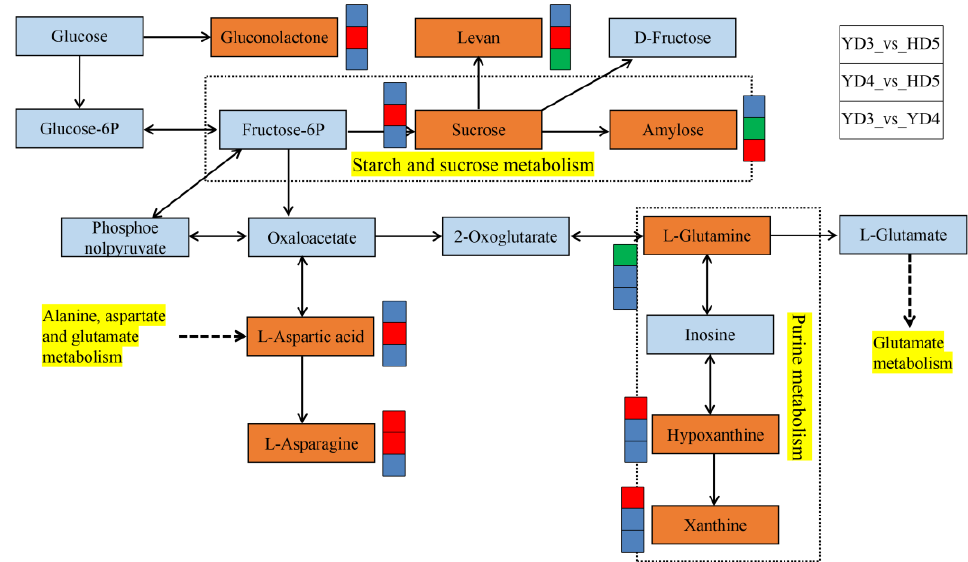
Figure 4 . Overview of key metabolites in the metabolic pathways of three conventional japonica rice varieties. The key metabolites are shown in orange rectangles. Red squares indicate significant upregulation of the metabolite content; green squares indicate significant downregulation of the metabolite content; blue squares indicate no significant difference in the metabolite content. Yellow represents the metabolic pathways.